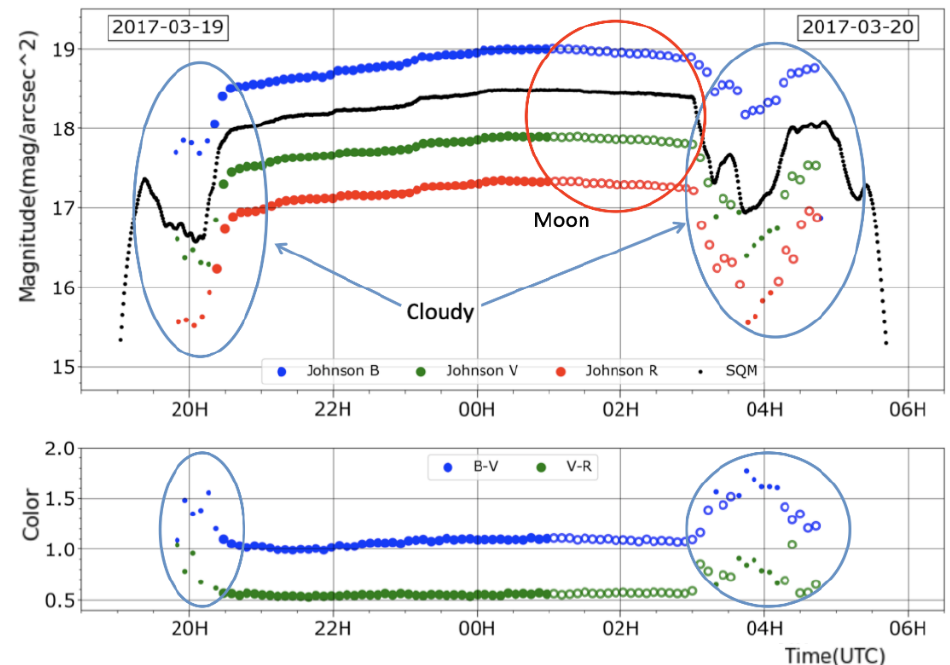
Figure 5. Brightness and color evolution of the sky during a typical night in Madrid. Blue, green, and red solid points represent the Johnson B, V, and R data with no moon and no clouds, as measured by AstMon. Observations with the moon over the horizon are marked with the same color code and open circles. Observations under cloudy skies (brighter and variable values) are marked with small points. Note how the color B-V and V-R indices (bottom graph) show distinctive values during the cloud episodes. SQM data are displayed as black points. Astronomical magnitude is a logarithmic inverse scale and mag/arcsec 2 values are lower for brighter skies.